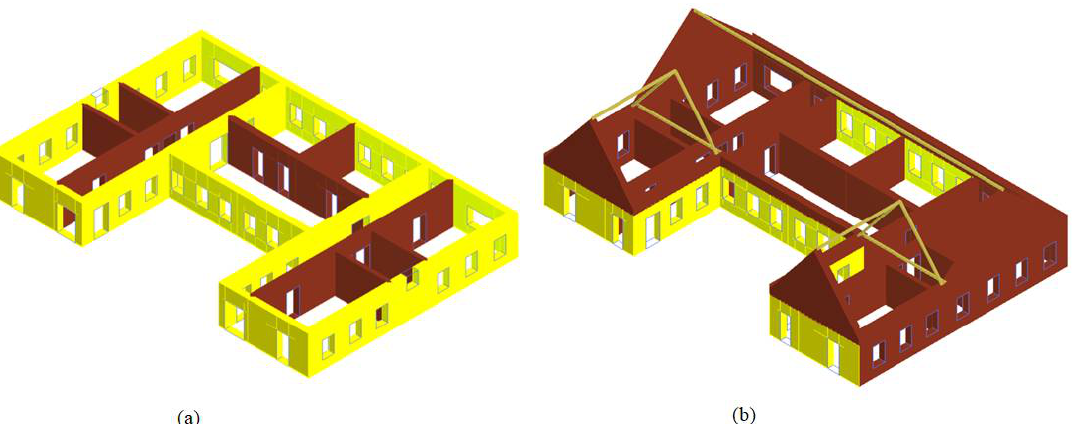
Figure 22. Configuration of shotcrete reinforcement (yellow color): ( a ) on the ground floor; ( b ) on the first floor.